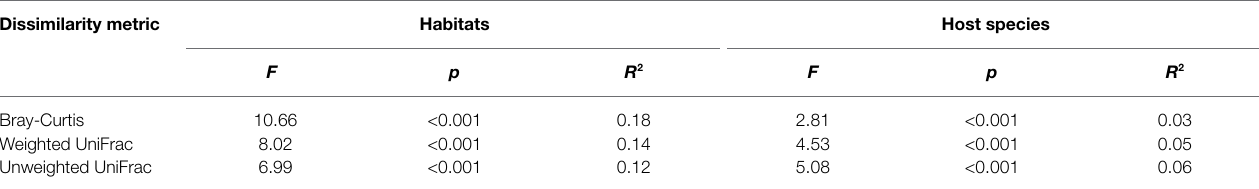
TABLE 1 | Results of PERMANOVAs testing for the effect of habitats and host species on gut microbiota in rodents, using three different dissimilarity metrics. Dissimilarity